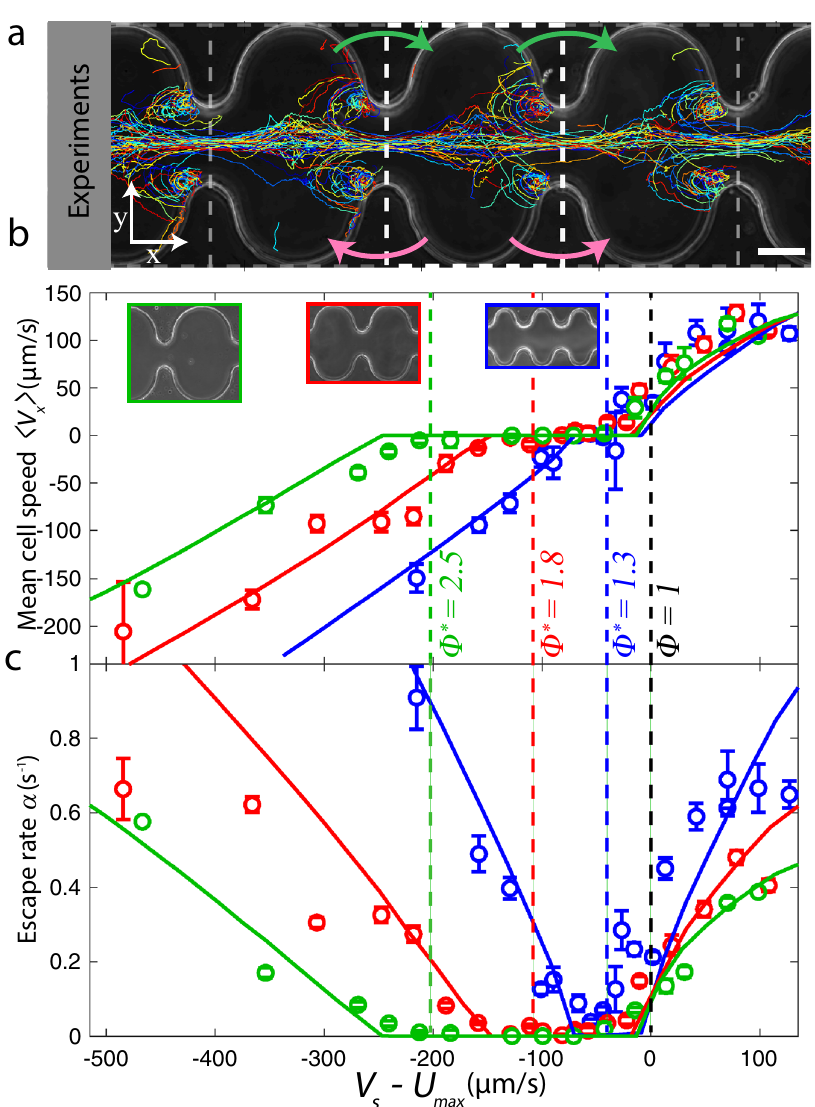
Fig. 2 Cell trapping at a constriction results in a bacterial diode effect, having three distinct transport regimes. a Corrugated microchannels ( w p / w t = 5; Φ = 2.8) enable periodic averaging of cell transport statistics from experimentally measured magnetotactic bacterial trajectories (670 tracks shown). Gray dashed lines represent periodic pore edges. Cell fl ux through a pore control volume (white dashed lines) in the upstream direction (green arrows) and positive cell fl ux out of a pore, J out (magenta arrows) determine the mean cell advection speed, 〈 V x 〉 , and pore escape rate, α , respectively. Scale bar, 50 μ m. b Mean upstream cell advection speed, 〈 V x 〉 , exhibits three transport regimes: upstream swimming, trapping, and downstream advection. Markers are experiments ( w p / w t = 3, blue; w p / w t = 4, red; w p / w t = 5, green), and solid lines are corresponding Langevin simulations. Vertical dashed black line corresponds to predicted limit of the upstream regime, Φ = 1 ( V s = U max ). Vertical dashed colored lines are predicted limits of the trapping regime, Φ * = U U V s = U α , re fl ect the non-marginal cell trapping. Markers and lines correspond to ( b ). Error bars max / min ( min ). c Bacterial pore escape rates (see a ), for ( b and c ) are standard errors of 9, 5, and 4 individual pores along the corrugated channel acquired simultaneously for w p / w t = 3, 4, and 5, respectively. Each data point is comprised of 3667 tracks on average with a minimum of 254 tracks across all